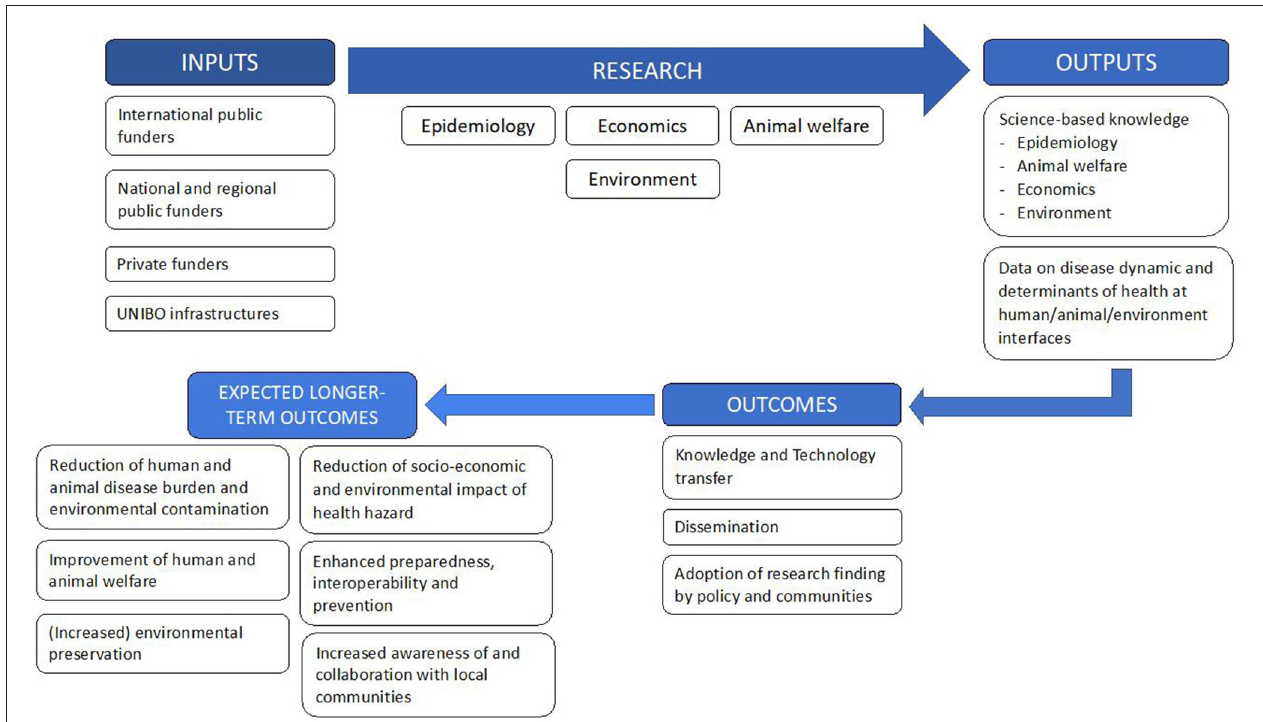
FIGURE 2 | Theory of change (TOC) of the UNIBO